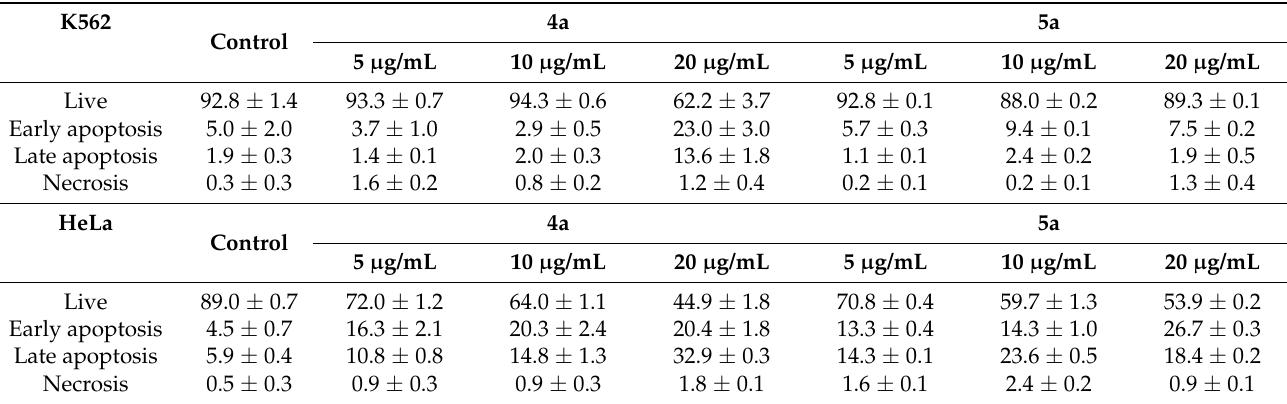
Table 3. Annexin V-FITC/Propidium iodide (PI) dual staining assay of K562 and HeLa cells treated with cycloadducts 4a and 5a at concentrations 5, 10 and 20 µ g/mL using flow